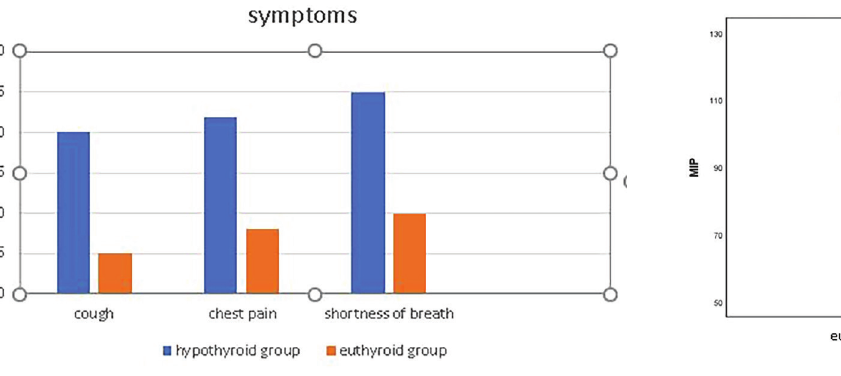
Figure 1 - Comparison of pulmonary symptoms of hypothyroid and euthyroid group